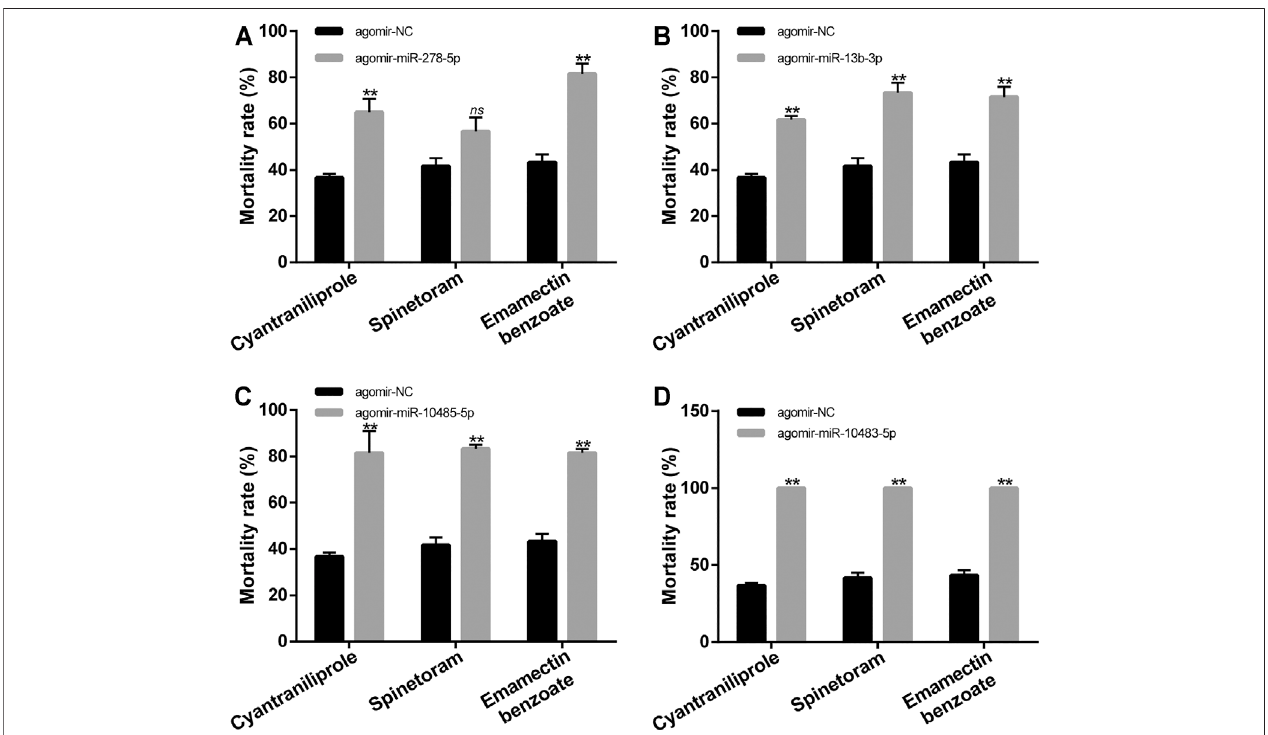
FIGURE 8 | Mortality of S. frugiperda with LC 50 doses of cyantraniliprole, spinetoram, and emamectin benzoate treatments after injection of miRNA agomir. (A) Mortality of S. frugiperda with LC 50 doses of treatment of three insecticides after injection of agomir-miR-278-5p. (B) Mortality of S. frugiperda with LC 50 doses of treatment of three insecticides after injection of agomir-miR-13b-3p. (C) Mortality of S. frugiperda with LC 50 doses of treatment of three insecticides after injection of agomir-miR-10485-5p. (D) Mortality of S. frugiperda with LC 50 doses of treatment of three insecticides after injection of agomir-miR-10483-5p. The asterisks (**) indicate p < 0.01. ns represents no signi fi cant difference. Results are shown as the average ± standard error